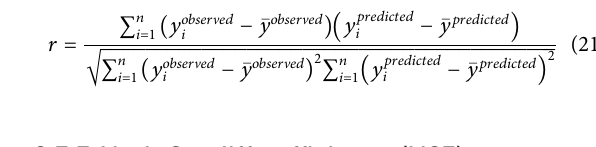
Frontiers in Environmental